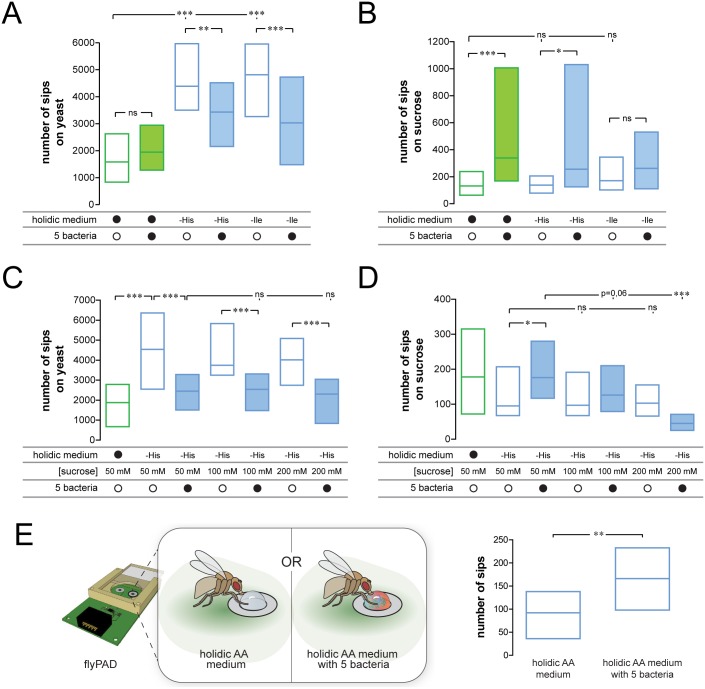
Commensal bacteria decrease yeast appetite upon essential amino acid (eAA) deprivation and are phagostimulators.Numbers of sips on yeast (A) or sucrose (B) of axenic flies prefed on holidic medium with different eAAs and with or without the commensal mix as measured using the flyPAD. n = 70–82. Numbers of sips on yeast (C) or sucrose (D) of axenic flies prefed on holidic medium containing different eAAs and different sucrose concentrations with or without the commensal mix as measured using the flyPAD. n = 25–37. (E) On the left, a diagram depicting the strategy used to test the phagostimulatory power of commensal bacteria. flyPAD drawing from [67]. On the right, numbers of sips of flies feeding from holidic base medium containing amino acids (AAs) with or without the commensal mix as measured using the flyPAD. n = 37–39. (A–E) Boxes represent upper and lower quartiles with the median. In this and other Figs, empty boxes represent non–bacteria-treated conditions and filled boxes represent bacteria-pretreated conditions. (A–D) Filled black circles represent a complete holidic medium or pretreatment with the bacteria mix. Open black circles represent flies not pretreated with bacteria mix. AA deprivation is indicated as –histidine (–His) or –isoleucine (–Ile) and in (C–D) sucrose concentration is indicated as values of 50 mM, 100 mM, or 200 mM. (A–C) Significance was tested using the Kruskal–Wallis test followed by Dunn’s multiple comparison test, in (D) using the Mann–Whitney test, and in (E) using the unpaired t test. Not significant (ns) p > 0.05, * p < 0.05, ** p < 0.01, *** p < 0.001. Underlying data used in this Fig are provided in S1 Data.